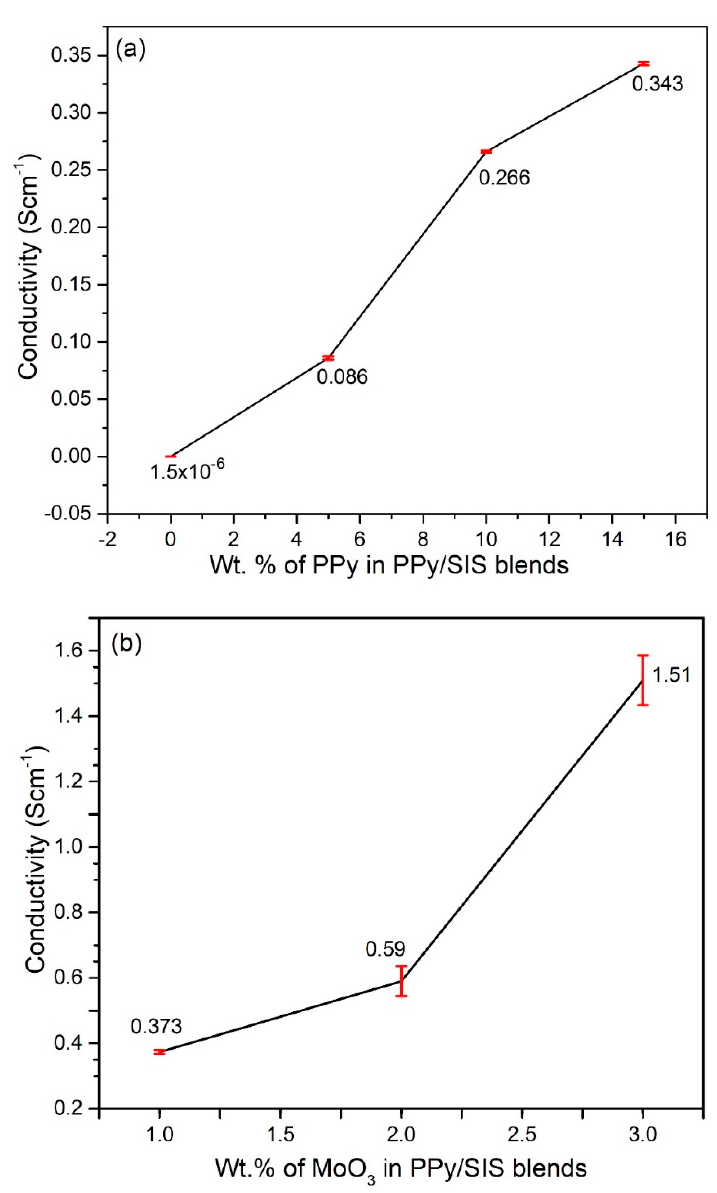
Figure8. Electricalconductivitytrendwithvariationin: ( a )Amount( w / w %)ofPPyinthePPy / SISblends; Figure 8. Electrical conductivity trend with variation in : ( a ) Amount (w/w %) of PPy in the PPy/SIS ( b ) Amount of MoO 3 nanobelts (1, 2, and 3 w / w %) in a selected polymer blend (15 w / w % PPy / blends; ( b ) Amount of MoO 3 nanobelts (1, 2, and 3 w/w %) in a selected polymer blend (15 w/w% PPy/SIS).